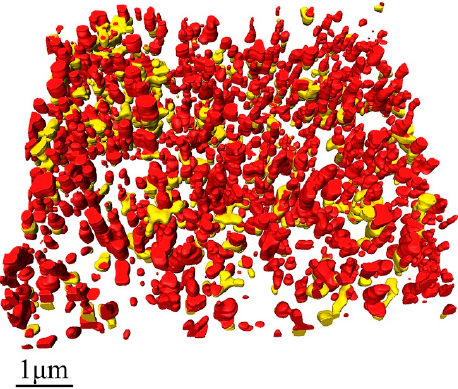
Figure 7. Rendering of the 3D spatial distribution of the TiO 2 particles after correction. The red parts are the original TiO 2 particles and the yellow parts are the shed parts of the TiO 2 particles that were the voids caused by particle shedding before correction.